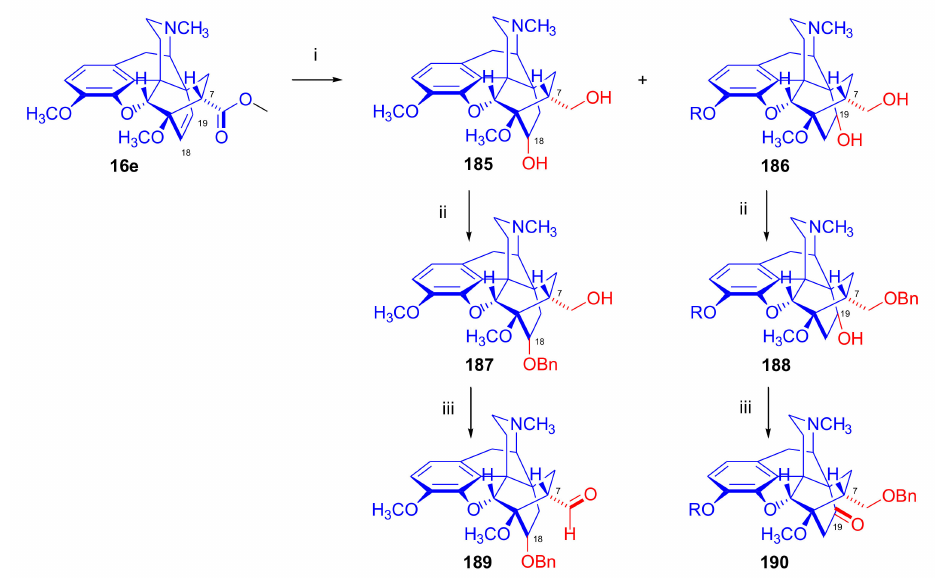
Figure 50. Preparation of 18- and 19-hydroxyl-substituted 6,14-ethenomorphinans and their benzyl derivatives. Reagents and conditions : (i): (1) BH 3 · Me 2 S, THF, − 65–70 ◦ C, (2) NaOH, 30% H 2 O 2 ; (ii): PhCH 2 Br, NaH, DMF, − 60 ◦ C, 1h; and (iii): DMP, CH 2 Cl 2 , 3 h.